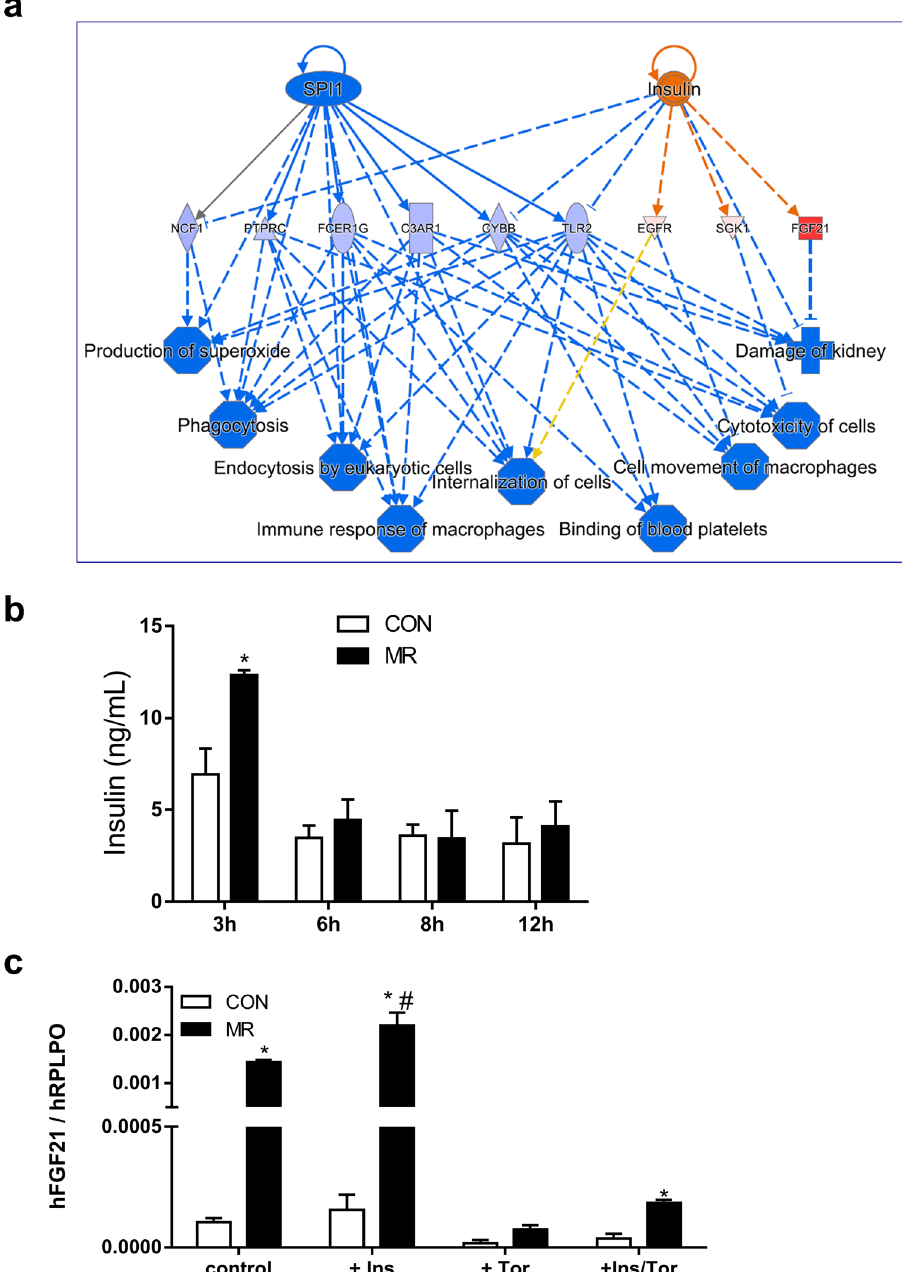
Figure 4. Activation of FGF21 by insulin is predicted by IPA (IPA Build version 458397 M; QIAGEN Inc., https ://www.qiage nbioi nform atics .com/produ cts/ingen uity-pathw ay-analy sis) after 6 h on MR ( a ). Serum insulin was measured from mice fed either Con or MR for 3 h, 6 h, 9 h, and 12 h ( b ). FGF21 expression was measured in HepG2 cells exposed to insulin (2 nM) in the presence and absence of Torin (200 nM) and cultured in either Con or MR ( c ). * Con different from MR; # MR without different from MR with 2 nM insulin; p <